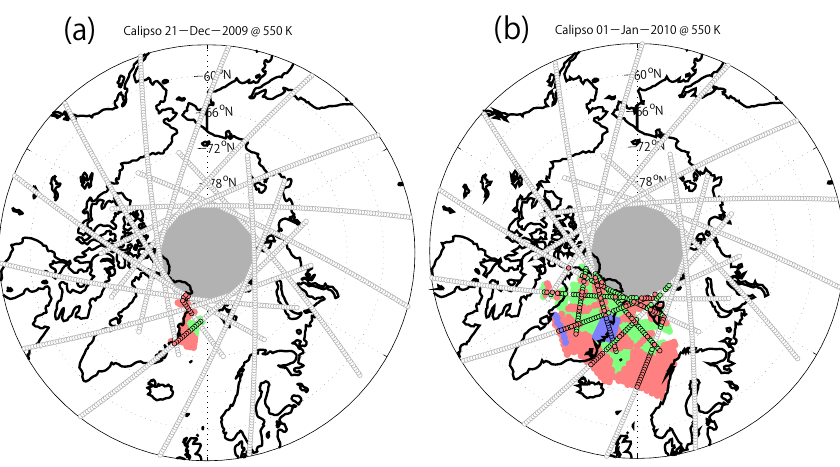
Figure 2. CALIOP PSC field for 21 December 2009 (a) and for 1 January 2010 (b) at the 550K potential temperature surface. The green area represents STS PSCs, the red area mixed NAT and STS PSCs, and the blue area ice PSCs. Grey and black circles show CALIOP observation points for nighttime orbit segments. No measurements are available in the grey area around the pole (>82 ◦ N) due to the orbital coverage of the CALIPSO satellite.